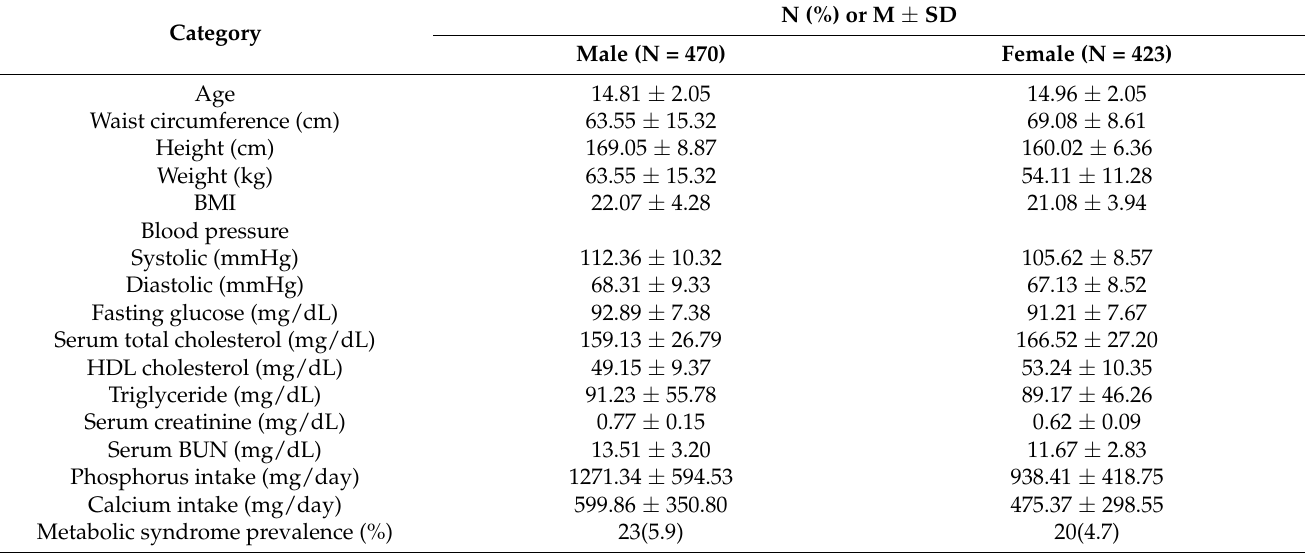
Table 1. General Characteristics of Participants (N =